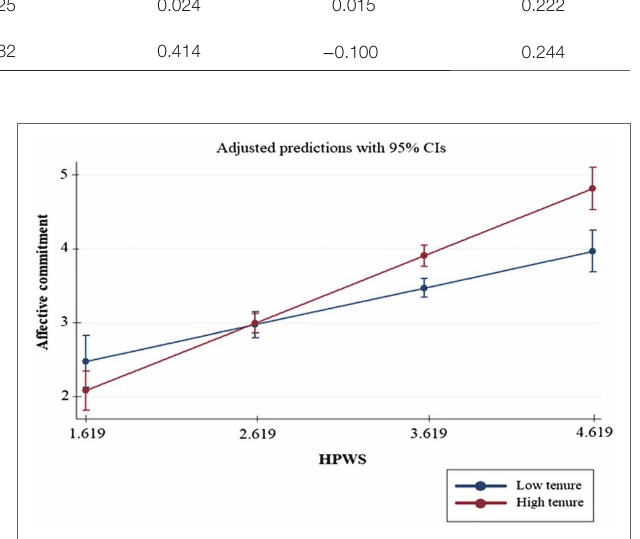
FIGURE 2 | Interaction plot—affective commitment.